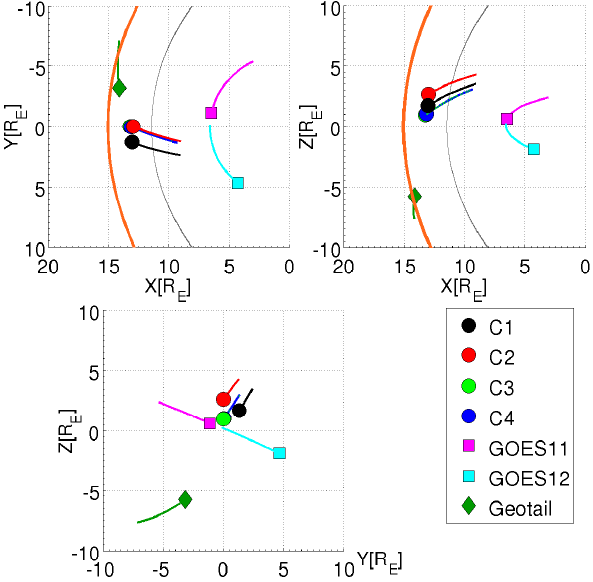
Fig. 2. The orbits of Cluster, GOES, and Geotail spacecraft on 17 March 2007, 17:00–20:30UT in Geocentric Solar Ecliptic (GSE) coordinates. The markers show the spacecraft locations at the end of the interval. The orange curve depict the model bow shock (Merka et al., 2005) and the grey curve the model magnetopause (Shue et al., 1998) for the observed upstream conditions.